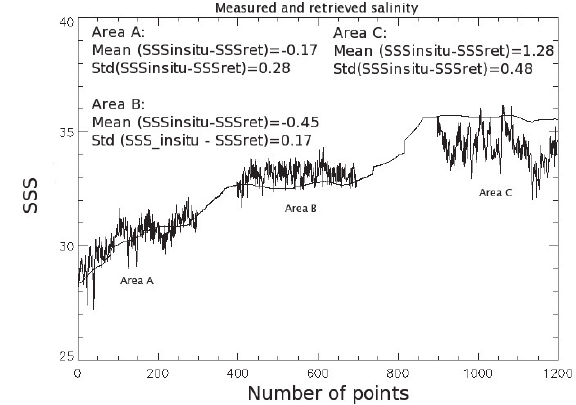
Fig . 4. – Retrieved salinity (noisy line) for the three areas (each area contain 300 measurements) compared with measured salinity (stable